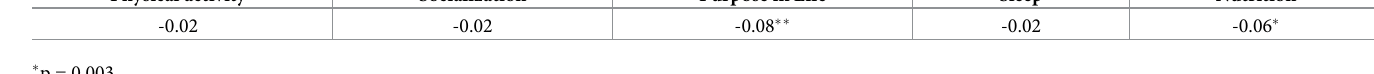
Table 7. Linear regressions between habit changes and mean scores (first and second questionnaires). Numbers in table are standardized beta coefficient. Physical